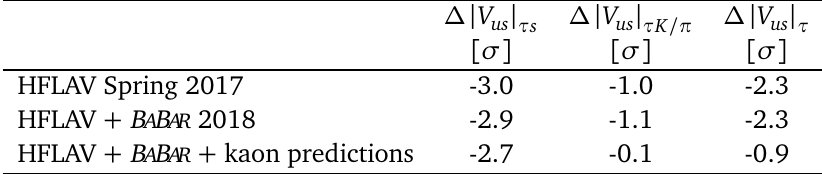
Table 1: Deviations of | V CKM unitarity. The second and third row use the | V